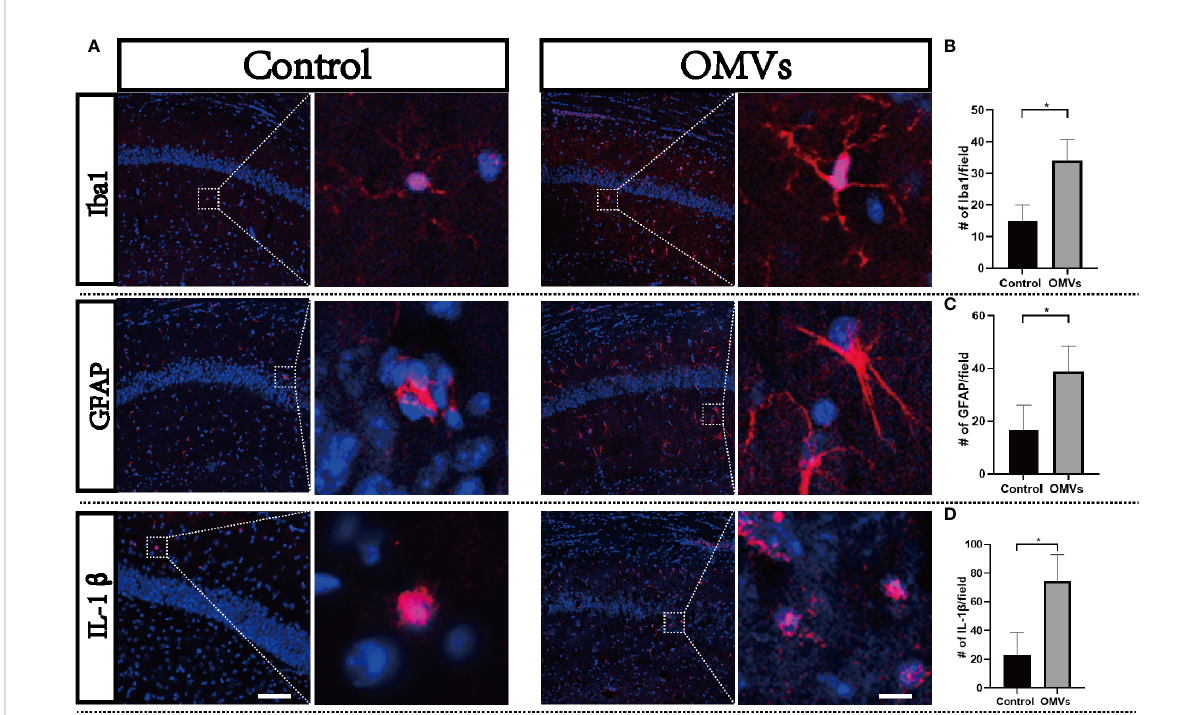
FIGURE 7 Oral gavage of Pg OMVs induces neuroin fl ammation. (A) Activation of microglia (Iba1 marker, red) and astrocytes (GFAP marker, red) and expression of IL-1 b (red) in the hippocampus of mice. Scale bar left = 50 m m, scale bar right = 5 m m. (B) Number of microglia (Iba1 positive) counted in the hippocampus from fi ve slides for each mouse and are means ± SEM; n = 3 mice/group. (C) Number of astrocytes (GFAP positive) in the hippocampus counted from fi ve slides for each mouse and are means ± SEM; n = 3 mice/group. (D) Number of IL-1 b positive cells in the hippocampus counted from fi ve slides for each mouse and are means ± SEM; n = 3 mice/group. * p